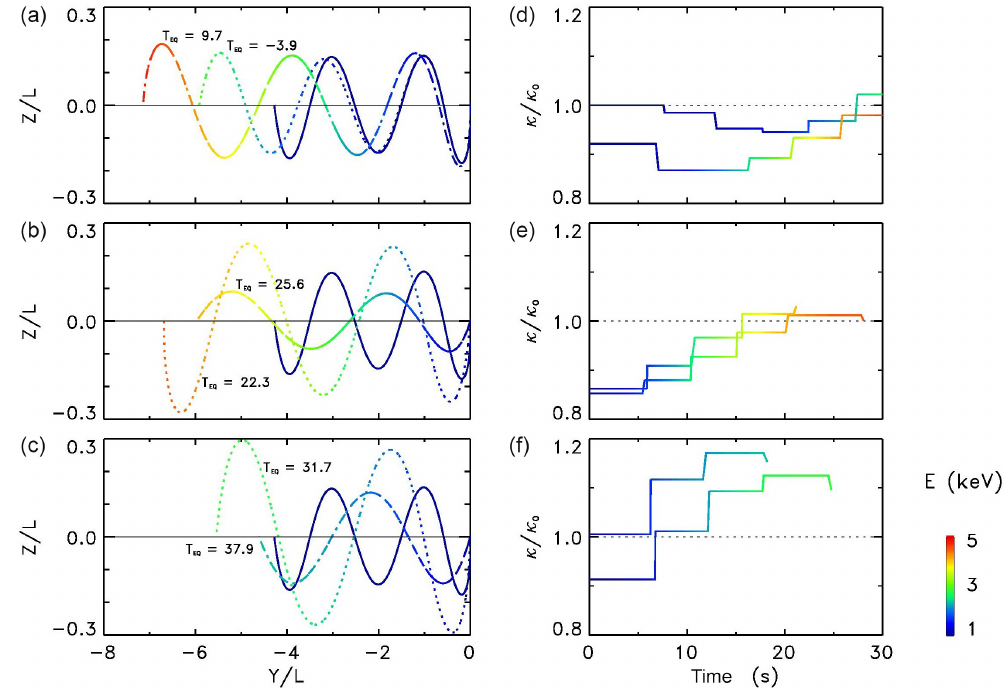
Figure 5. From top to bottom in left panels: meandering trajectory sequences during field line dipolarization for different equatorial crossing times (the time of the first equatorial crossing is indicated for each trajectory). The H + trajectory shown in blue is the reference trajectory in the pre-dipolarization configuration. From top to bottom in right panels: corresponding κ parameters (normalized to the value in the pre-dipolarization configuration) as a function of time. The instantaneous H + energy is coded according to the color scale on the right.